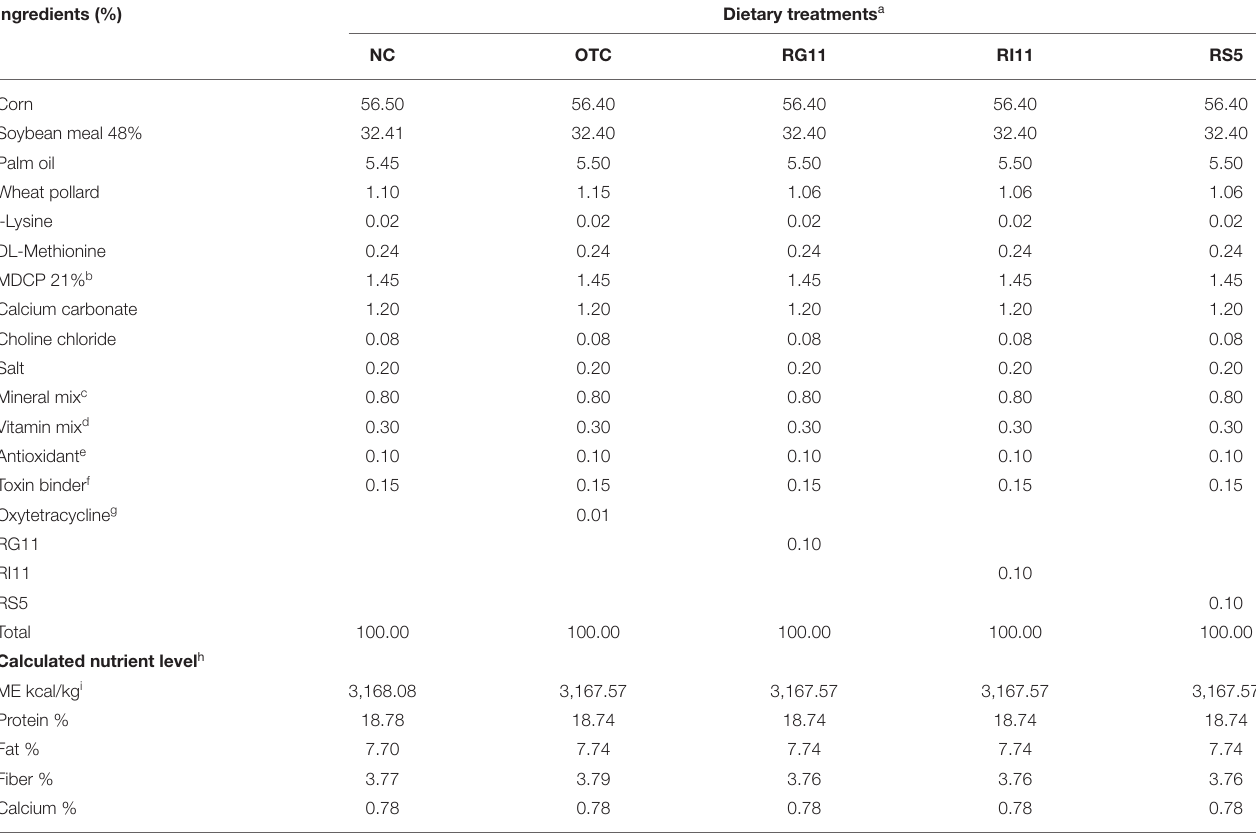
TABLE 2 | Ingredient composition and nutrient contents of the finisher diet. Ingredients (%) Dietary treatments a NC Corn